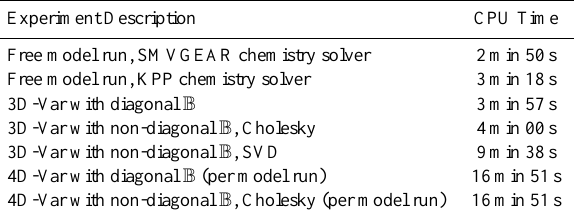
Table 1. Timing results for GEOS-Chem free model run, 3D-Var and 4D-Var data assimilations with diagonal and non-diagonal B for a 24-h simulation starting on 1 July